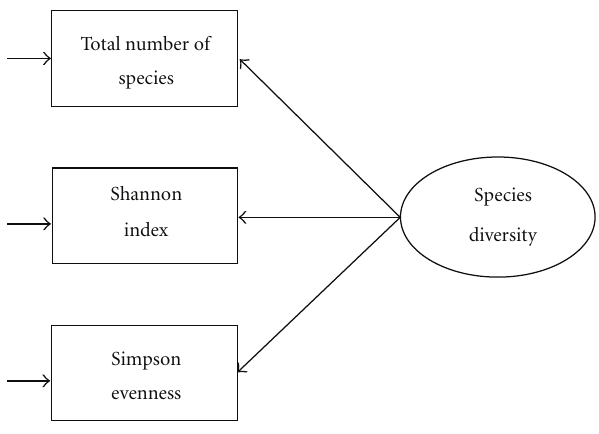
Figure 2: A hypothetical measurement model for species diversity. The circle depicts a latent variable and the rectangles depict ob- served variables. Single arrowheads from the latent variable to the observed variables represent direct e ff ects and arrows on the left of observed variables represent measurement